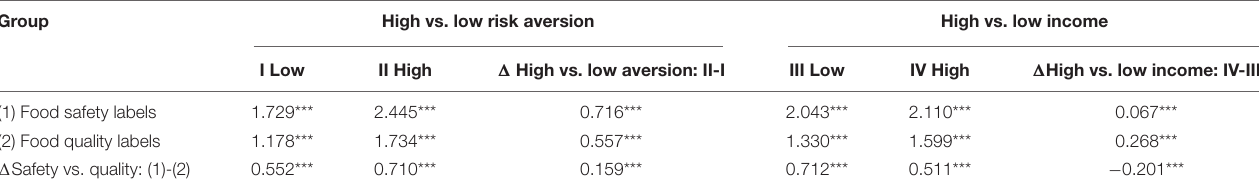
TABLE 5 | WTP differences for food safety vs. quality labels within and between subsamples.